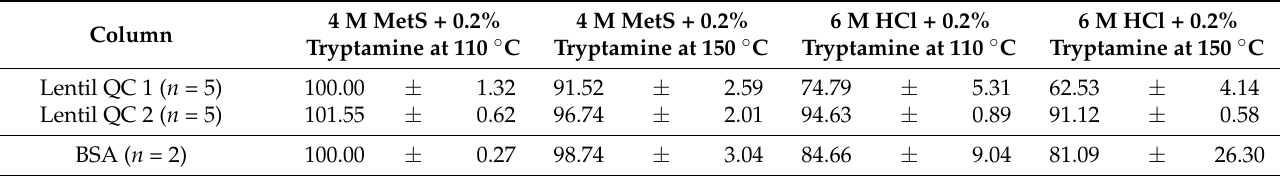
Figure 2. The pH stability achieved by 1:10 dilution with 0.01 M borate buffer following neutralisa- tion with NaOH (4 M or 6 M) ( n = 5).